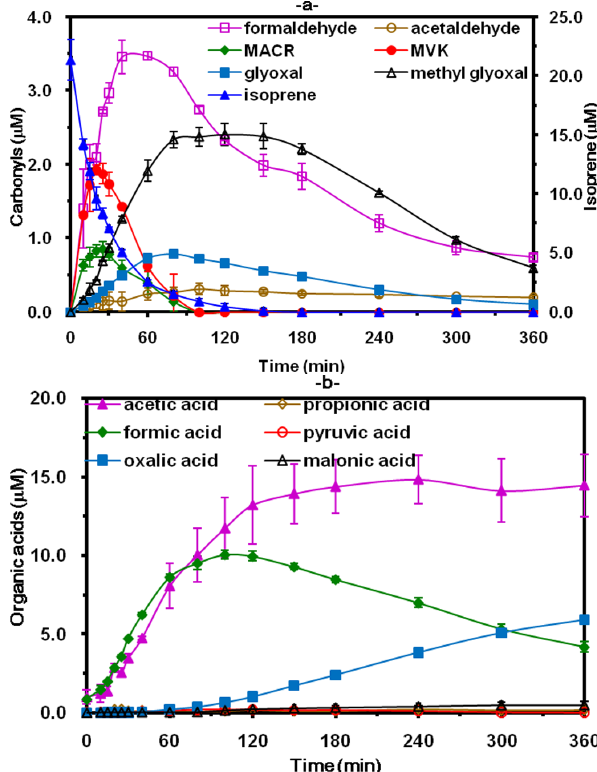
Fig. 1. The major products from the aqueous OH radical-initiated isoprene oxidation. (a) The time course of the oxidation of isoprene and the concomitant production of carbonyls. (b) The time course for the production of organic acids.